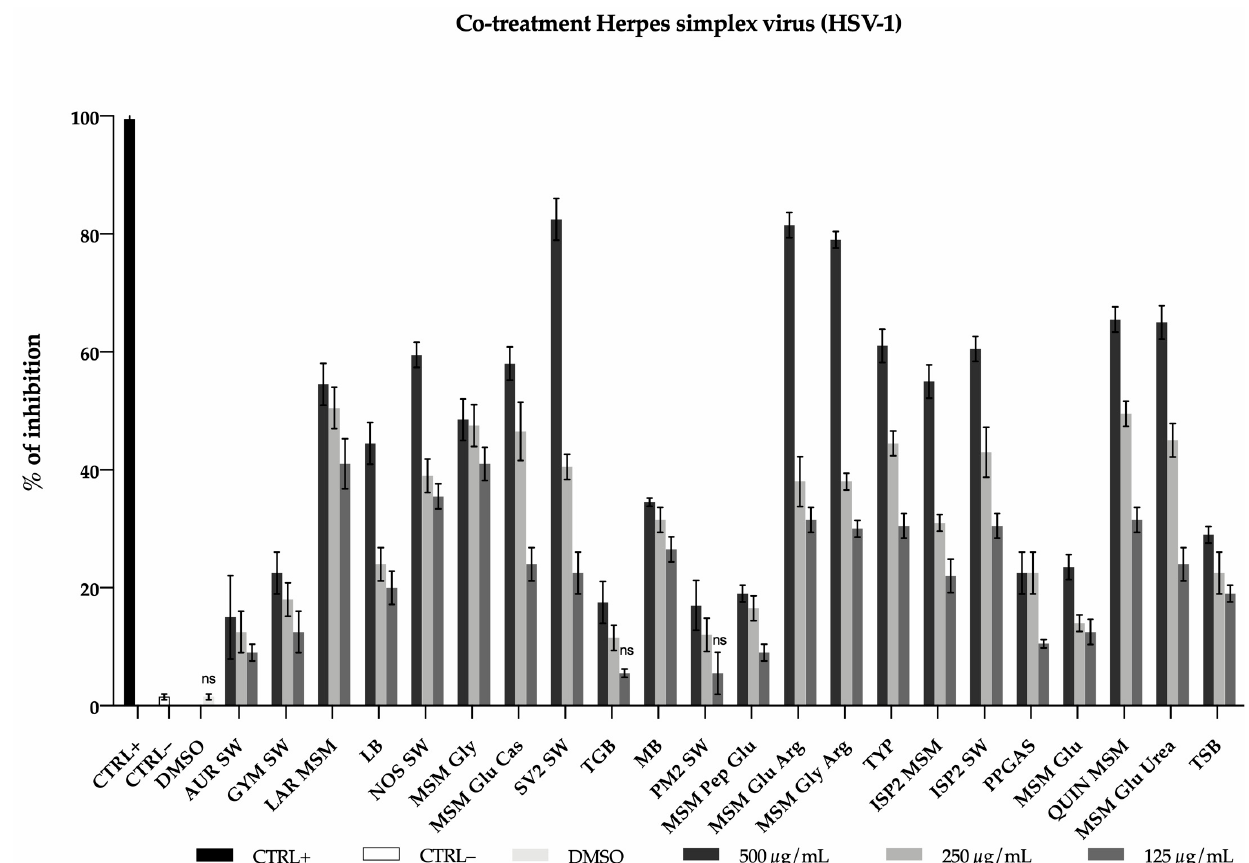
Figure 2. Evaluation of the antiviral activity of 22 crude extracts derived from Rhodococcus sp. I2R towards herpes simplex virus type 1 (HSV-1). The percentage of inhibition was calculated by counting the number of plaques obtained in the presence of extract compared to the untreated virus (CTRL–). The Greco extract [25] at 50 µg/mL was used as a positive control (CTRL+). Data are means of three independent experiments. Statistical significances are referred to the negative control (CTRL–). Differences between groups were determined by analysis of variance (ANOVA) and Dunnett’s test was used for multiple comparisons with the control. Statistically not significant values are indicated with “ns”, otherwise p < 0.005.